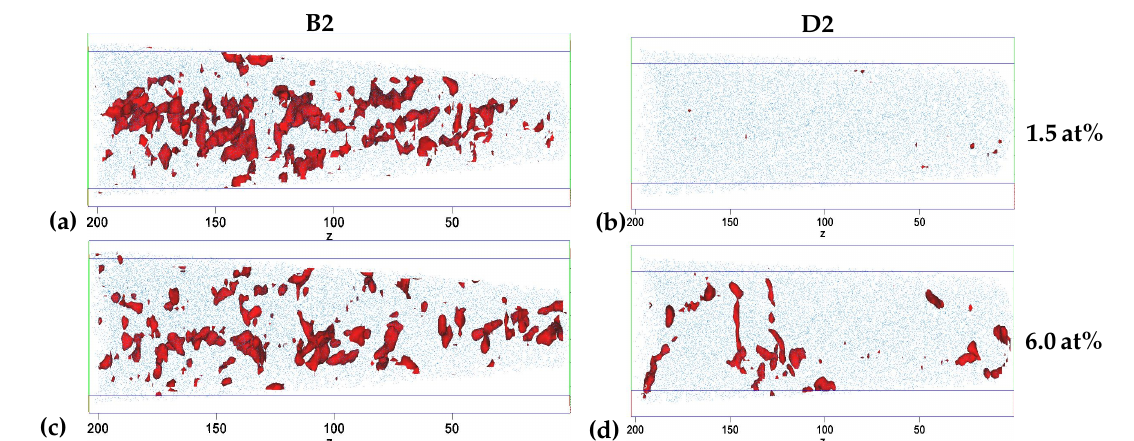
Figure 3. Carbon iso-concentration surfaces of tip ( a , c ) B2 and ( b , d ) D2 visualizing volumes with carbon content ( a , b ) below 1.5at% and ( c , d ) above 6.0at%. Fe atoms are added in blue to show the tip volume and length scale in nm.